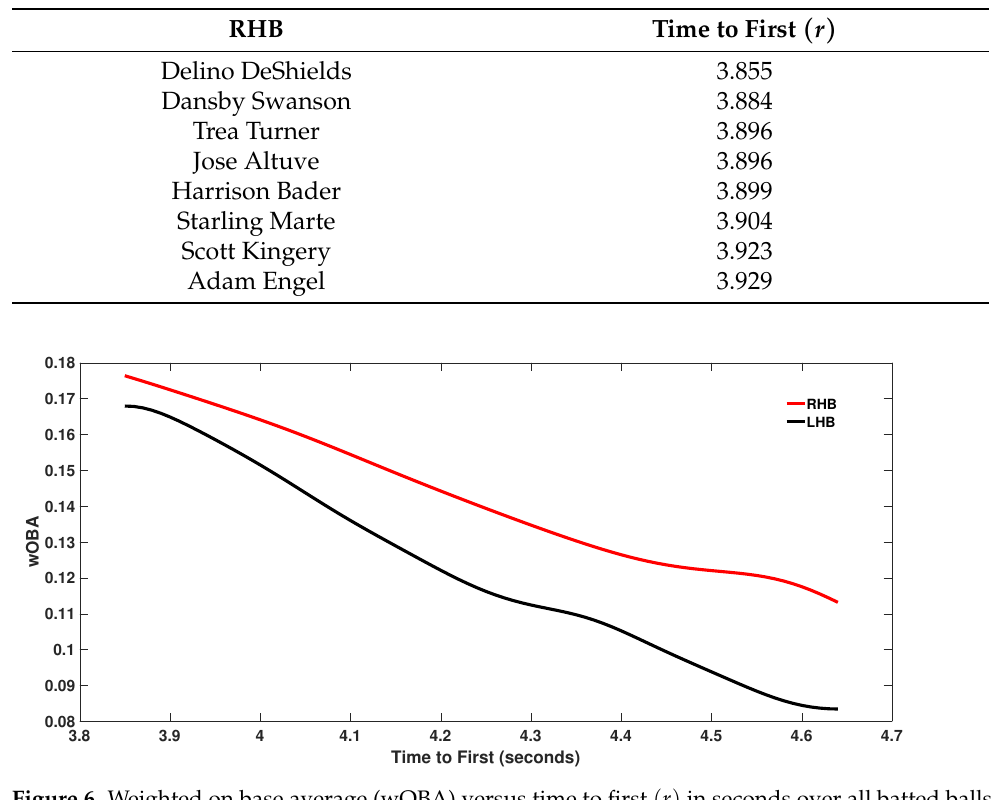
Figure 6. Weighted on base average (wOBA) versus time to first ( r ) in seconds over all batted balls with a vertical angle v < 10 ◦ for right-handed batters (RHB) and left-handed batters (LHB) in 2018.